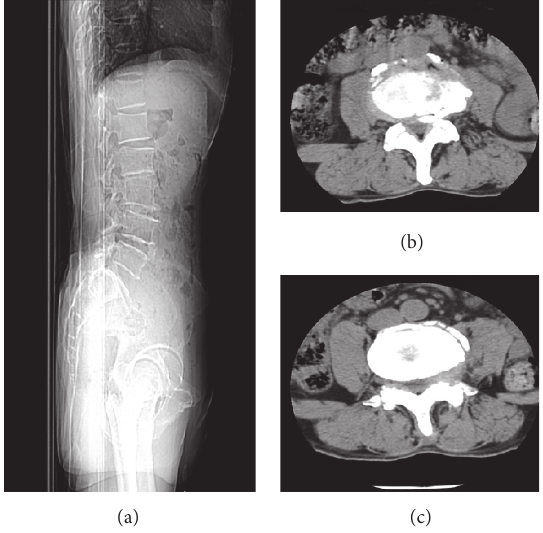
Figure 2: The sagittal (a) and coronal CT images of L3-4 (b) and L4-5 (c) revealed lumbar stenosis combined with intervertebral disc herniation at both levels and combined lumbar facet joint degenerative